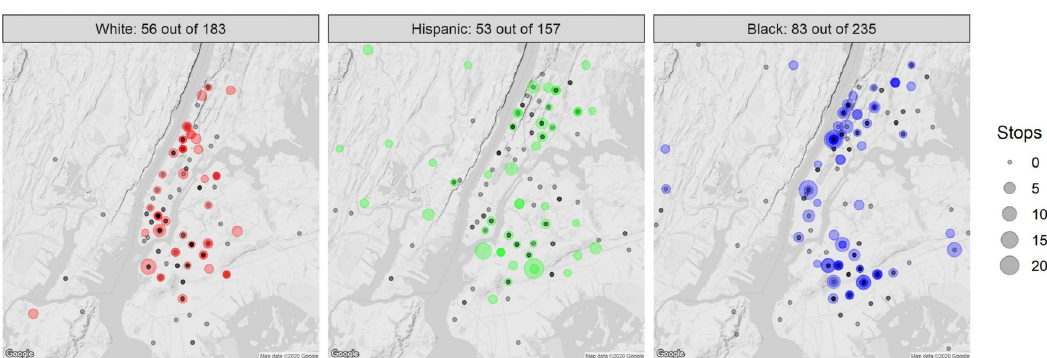
Fig 3. Geographic distribution of past year stop-and-frisk among P18 participants at cohort baseline, by race: P18 participants are mapped by participant ZIP code of residence. Those with a history of stop-and-frisk are indicated by red circles (White race), green circles (Hispanic/Latinx race/ethnicity), blue circles (Black race) with increasing circle size indicating increasing number of stop-and-frisk events, while those with no stop-and-frisk history are indicated by Black circles.